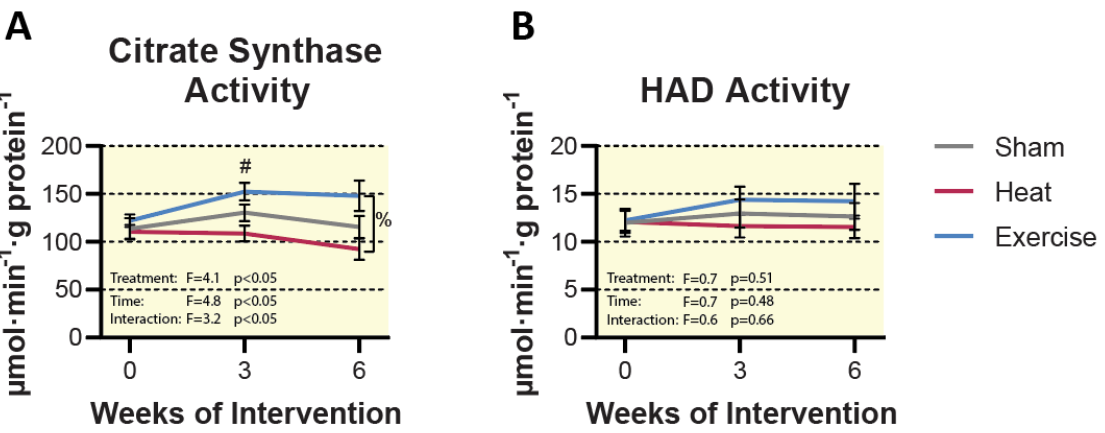
Figure 4. Citrate synthase and HAD activity. ( A ) Citrate synthase activity. ( B ) HAD activity. Statistical difference in the EX group compared to baseline is indicated by # ( p < 0.05). Statistical differences between groups are indicated by % ( p < 0.05). Results are represented as mean ± SEM ( n =